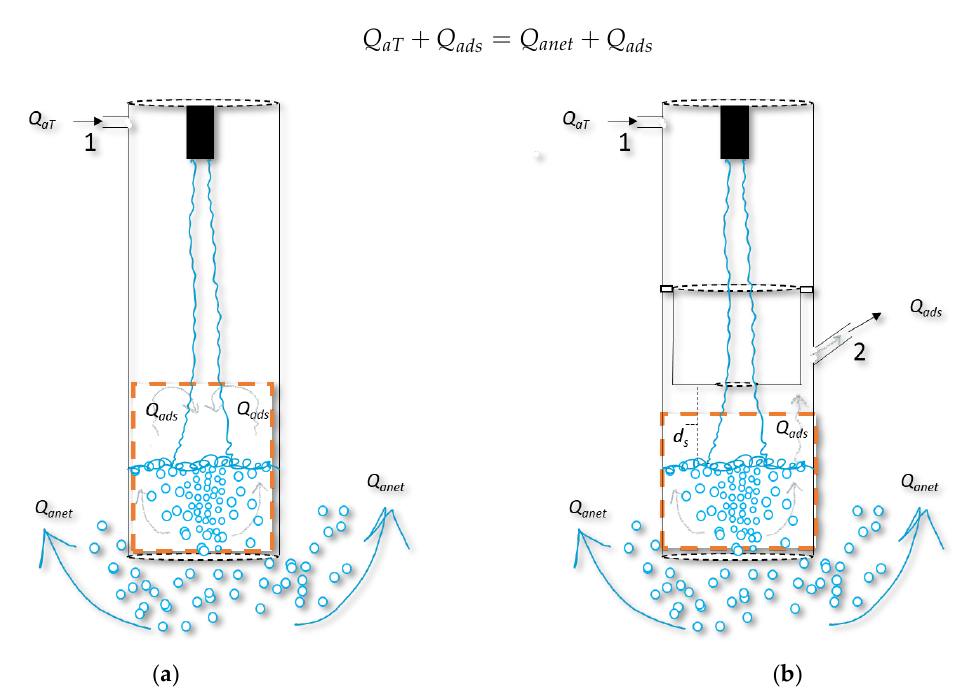
Figure 6. Schematic of the ( a ) standalone downcomer and ( b ) novel ADR downcomer including the control volume around the two-phase flow mixture inside the downcomer.